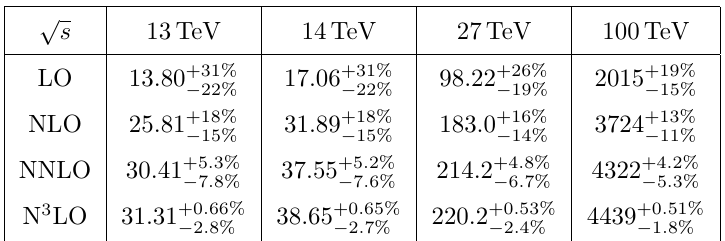
Table 3 . The inclusive total cross sections (in unit of fb) of Higgs boson pair production in the in(cid:12)nite top-quark mass limit at di(cid:11)erent centre-of-mass energies relative uncertainties are from the 9-point scale variations. The errors due to the numerical Monte Carlo integration are well below